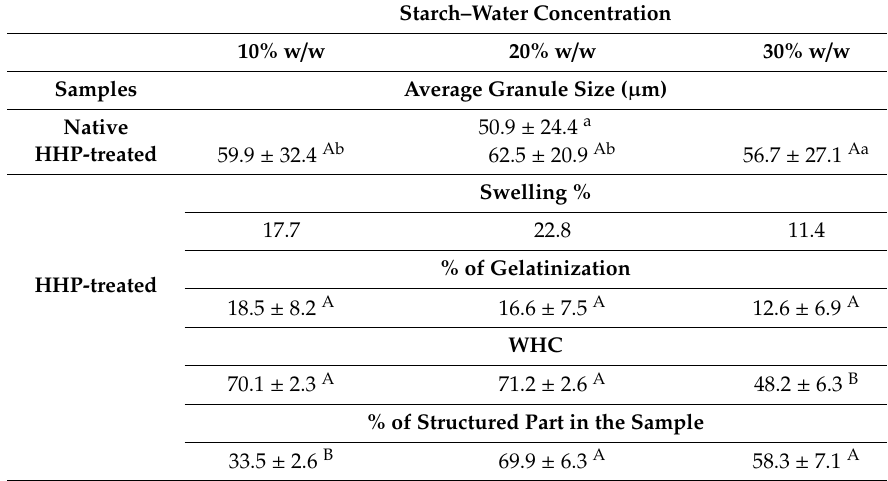
Table 1. Optical and physical parameters of untreated and high hydrostatic pressure (HHP) treated (600 MPa for 15 min at 25 ◦ C) potato starch suspensions at di ff erent starch concentration.